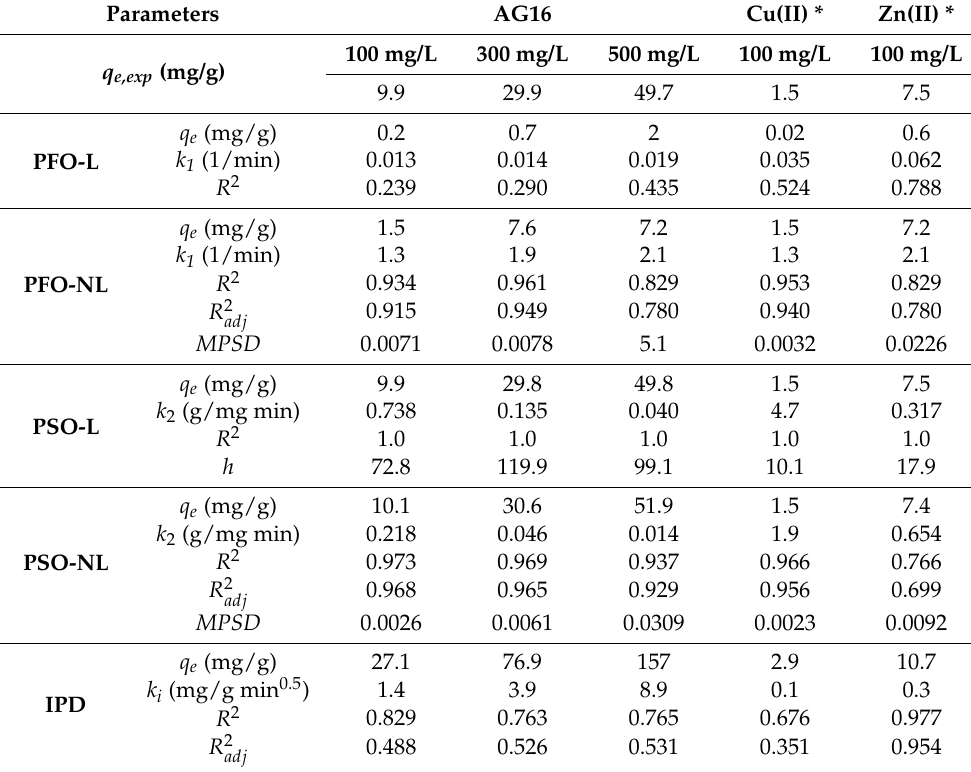
Table 3. Kinetic parameters for AG16, Cu(II) and Zn(II) sorption on Lewatit S5528.